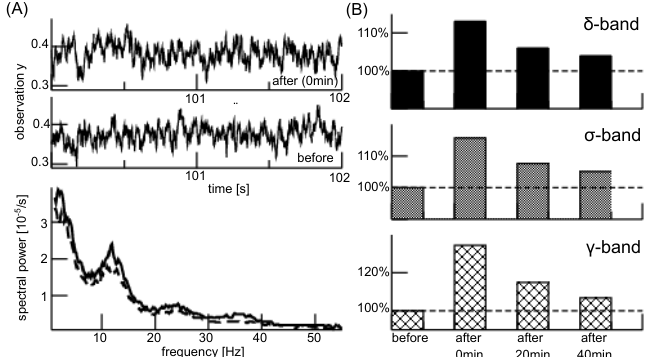
Figure 4. Long-duration anodal tDCS impact on EEG. ( A ) Upper panels: simulated EEG time traces before a-tDCS stimulation and immediately after. Lower panel: the corresponding power spectral density distributions for activity before (dashed line) and immediately after (solid line) stimulation. ( B ) Relative power change with respect to power before stimulus for different time periods after stimulation. Plasticity effects are modeled by an increase of excitatory efficacy with factors f tDCS = 1.2 (0 min after stimulation), f tDCS = 1.1 (20 min after stimulation) and f tDCS = 1.05 (40 min after stimulation). We assume a stimulation duration time of 12 min, implying the plasticity time scale τ plast = 1 min and a decay of the plasticity effect with τ decay = 30 min. In addition, the = f excitatory synaptic efficacy to ARAS input is f resp tDCS tDCS